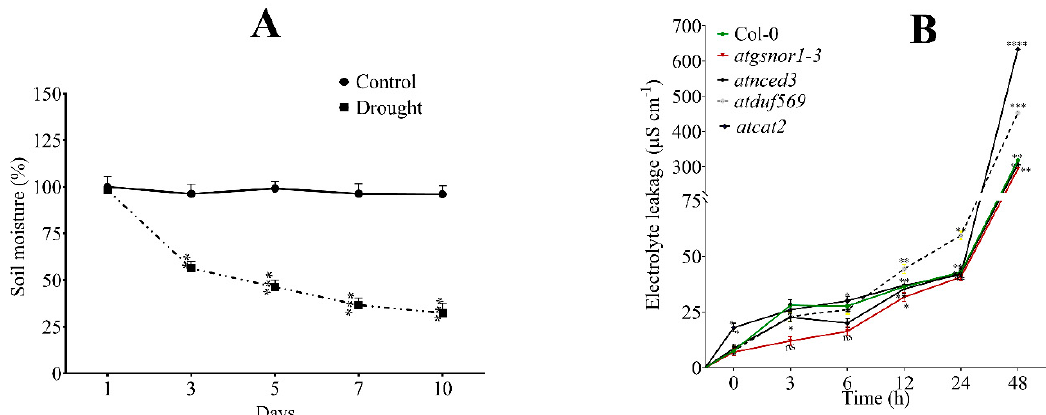
Figure 3. Soil moisture content and electrolyte leakage activity of the given Arabidopsis plants under drought stress. ( A ) The soil moisture content of the atduf569 knockout mutant genotype under drought-stressed conditions by recording the loss of weight during the experiment. ( B ) Electrolyte leakage of Col-0, atgsnor1-3 , atnced3 , atduf569 , and atcat2 under the drought stress. Data represent means of values obtained from experiments performed in triplicate. Error bars represent standard deviation. Means were analyzed for significant differences using Student’s t -test. Asterisks * indicate significant differences at 5% level of significance (**** p < 0.001, *** p < 0.001, ** p < 0.01, * p < 0.05).